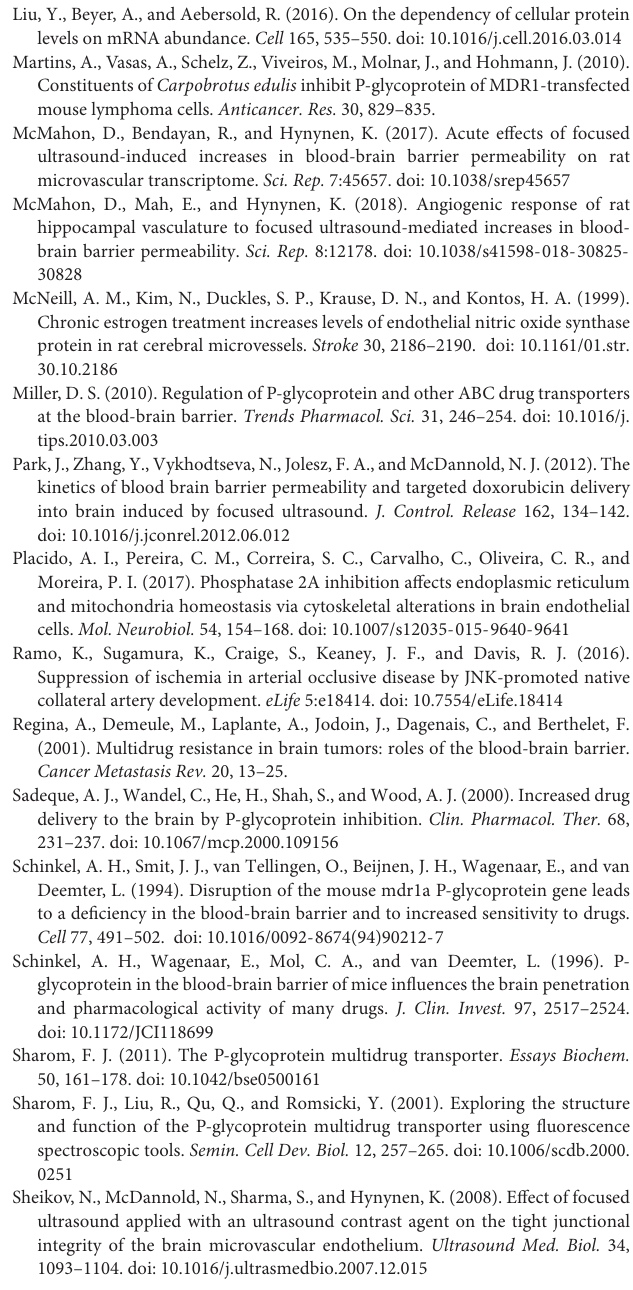
FIGURE S1 | The fluorescence image of Evans blue dye at 24 h after BBBD. (A) An axial view of T1-weighted image was obtained immediately after BBBD. (B) Evans blue was injected immediately after FUS and detected by fluorescence at 24 h post-BBBD